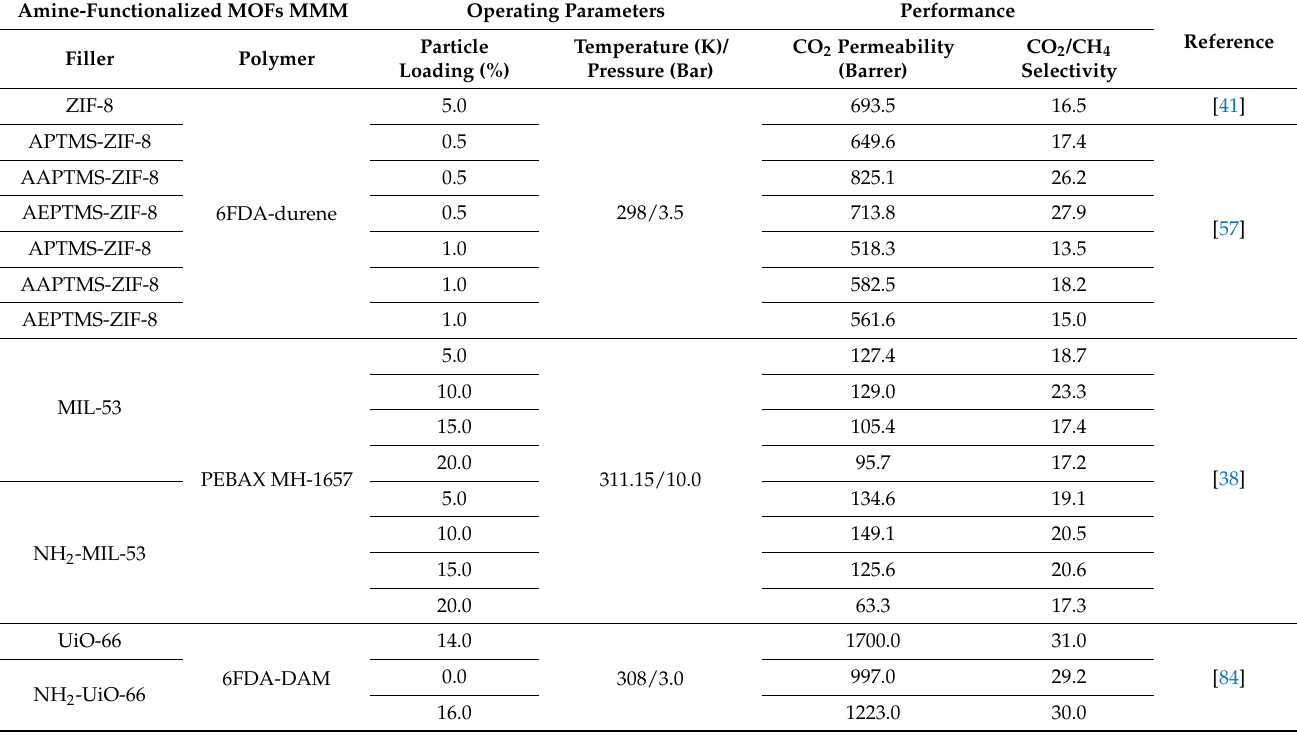
Figure 6. The Robeson plot of CO 2 /CH 4 gas pair selectivity against CO 2 permeability for MMMs; MIL-53/6FDA-ODA and NH 2 -MIL-53/6FDA-ODA [13], ZIF-8/6FDA-durene and NH 2 -ZIF-8/6FDA- durene [81], MOF-199/6FDA-ODA and NH 2 -MOF-199/6FDA-ODA [83], and MIL-125/Matrimid 9725 and NH 2 -MIL-125/Matrimid 9725 [17]. Table 2. Summary of the performances of amine and non-amine functionalized MOFs based mixed matrix membrane for CO 2 /CH 4